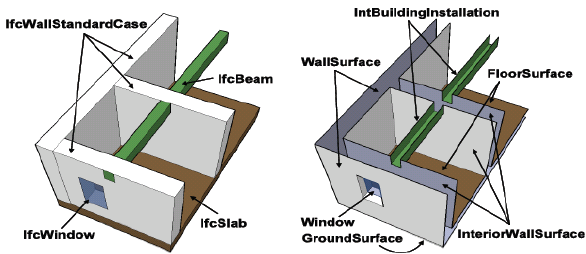
Figure 2: Building component representation in IFC [left] and surface representation in CityGML [right] In CityGML many building components like foundation, columns, beams, slabs, connections and other structural aspects are not modelled or all are represented by generic objects like "building installations" without the details of each specialised component. In addition, the building components are